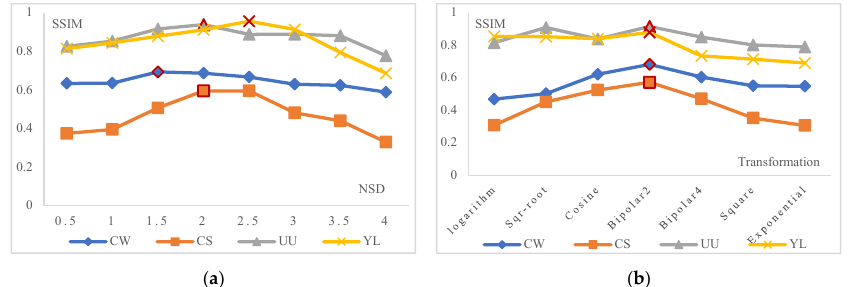
Figure 6. SSIM values of different ( a ) greyscale thresholding-NSDs and ( b ) greyscale transformations at the optimised SSIM = 2. Markers with red boundaries indicate optimal NSD and transformation scale. The red-bordered symbols refer to the highest values.